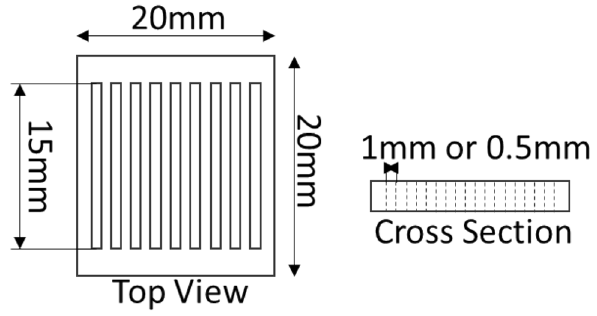
Figure 1. Mechanical drawing of acrylic master mold for agarose stamp